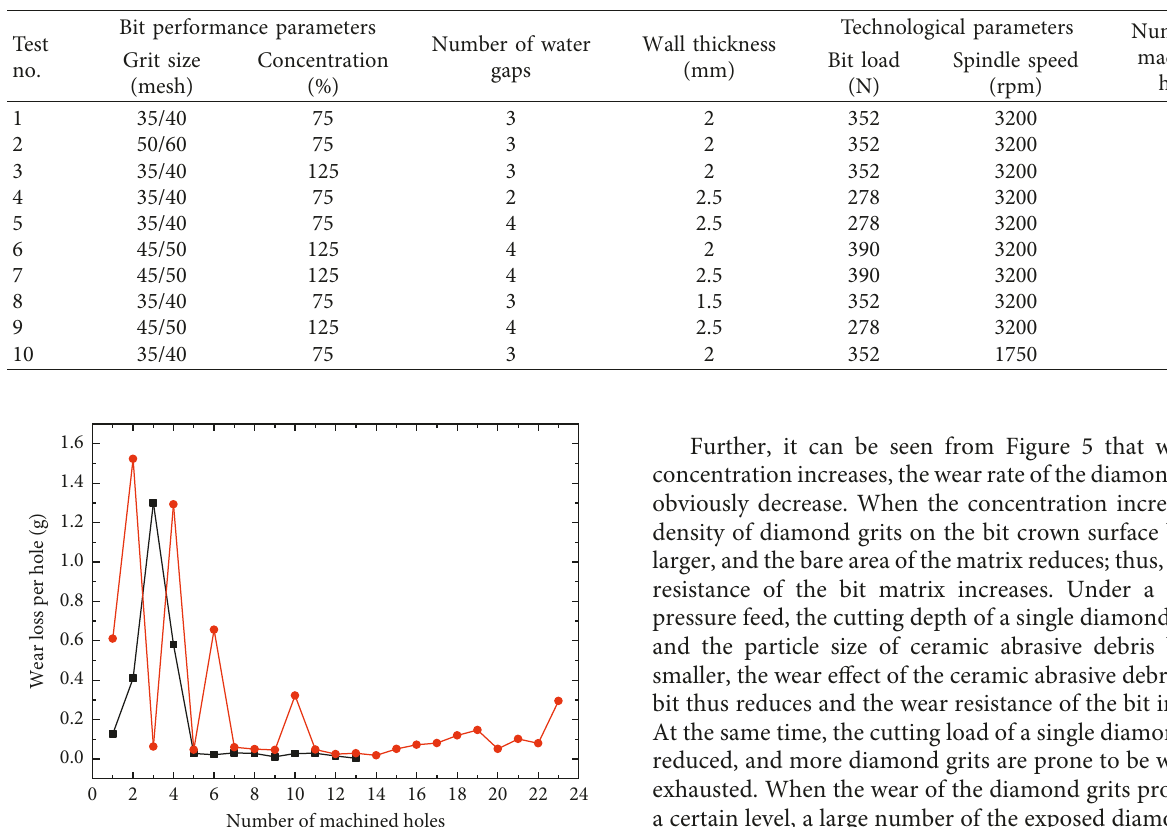
Table 1: Test conditions.